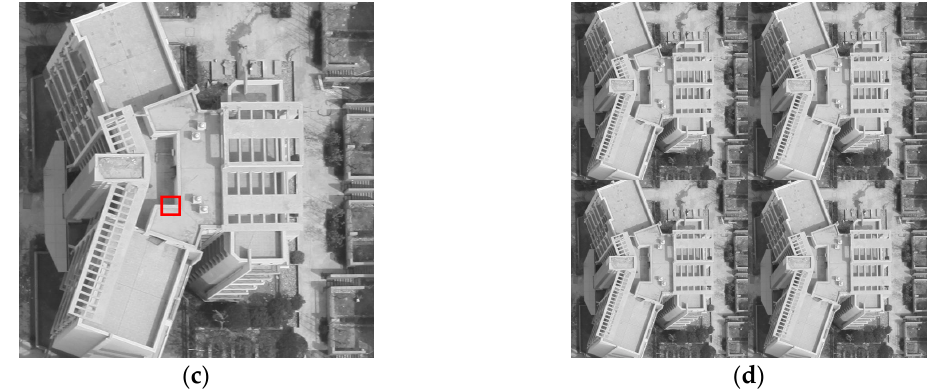
Figure 4. Experimental data. ( a ) Original ADS 40 image, the image enclosed in red box is the knife-edge area which is used to estimate the Gaussian function parameter ( σ ); ( b ) Four downsampled LR images of the ADS 40 image; ( c ) Original UAV image; ( d ) Four downsampled LR images of the UAV image.